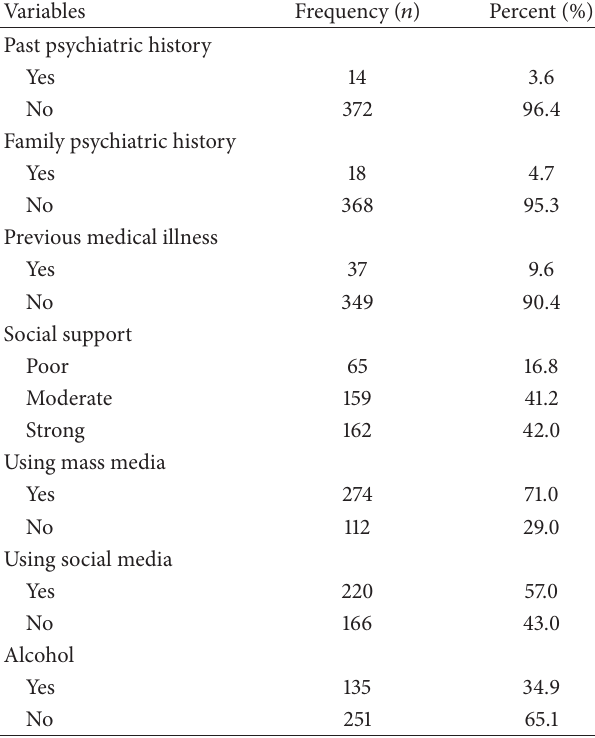
Table 1: Sociodemographic distribution of the respondents ( 𝑛 = 386 ).